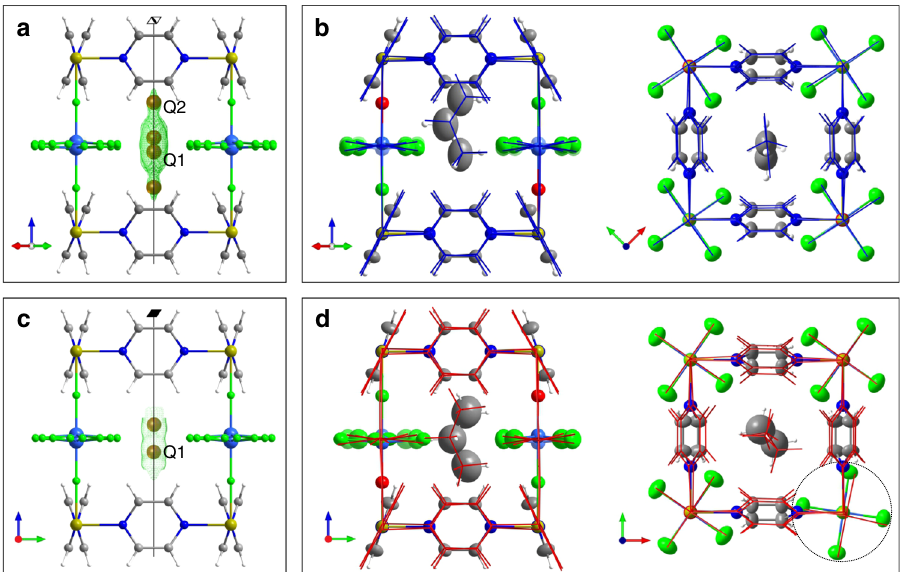
Fig. 4 Crystal structures of NbOFFIVE-1-Ni with guests. a Difference Fourier map for NbOFFIVE -1-Ni·0.85(propylene) showing diffuse electron density and two pairs of peaks (Q1 and Q2) in the cavity corresponding to a disordered propylene molecule. b Overlay of the experimental NbOFFIVE -1-Ni·0.85 (propylene) (displacement ellipsoids at 50% probability) and DFT (blue sticks corresponding to the global energy minimum B ) models of a single cavity. c Difference Fourier map for NbOFFIVE -1-Ni·0.81(propane) showing diffuse electron density and a pair of equivalent peaks (Q1) in the cavity corresponding to a disordered propane molecule. d Overlay of the experimental NbOFFIVE -1-Ni·0.81(propane) (displacement ellipsoids at 50% probability, the rotated anion is circled) and DFT (red sticks corresponding to the global energy minimum E ). b and d show one of the four orientations of the guest with the associated framework components, from the directions perpendicular and along the